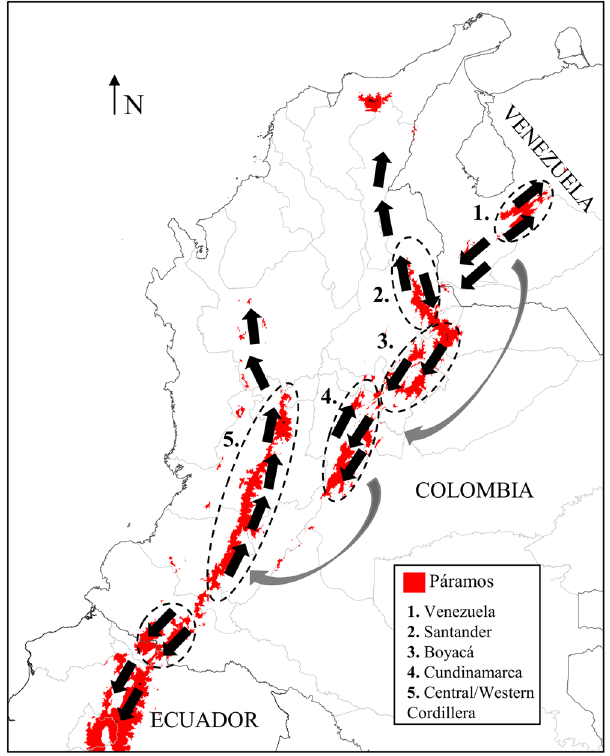
Figure 1. Migration routes of the genus Espeletia proposed by Cuatrecasas (2013) from its center of origin in Venezuela. Dashed circles correspond to the main centers of biogeographic diversification. Map created using DIVA-GIS software, version 7.5.0.0 available at